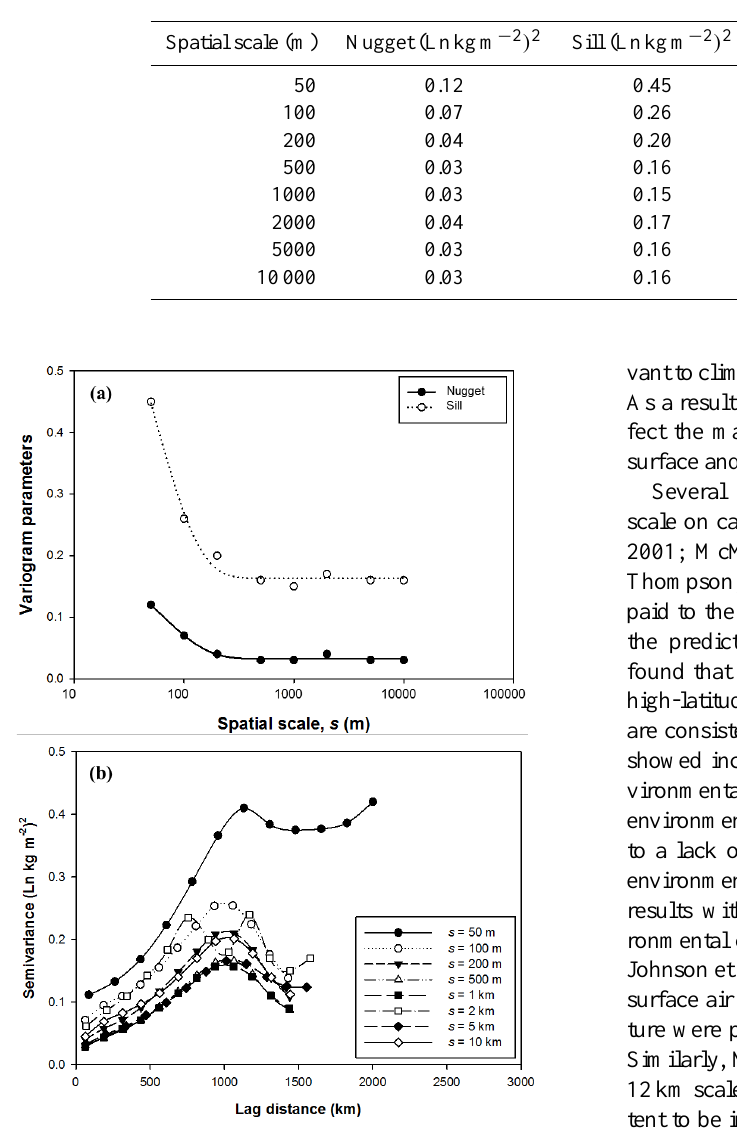
Table 2. Modeled variogram parameters of predicted soil organic carbon stocks at various spatial scales.